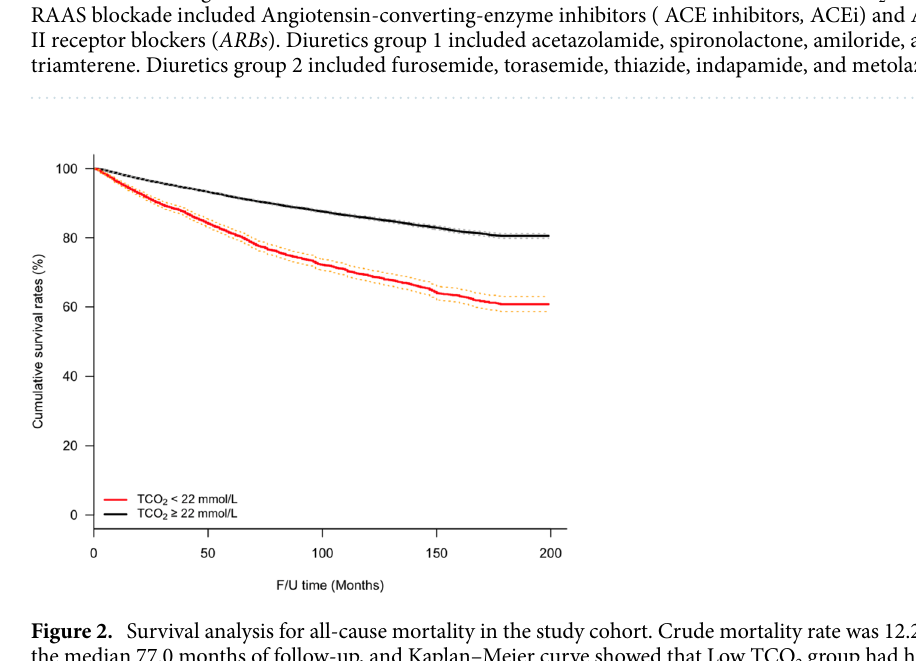
Table 1. Baseline characteristics and demographics according to the stage of chronic kidney disease. The data are expressed as the proportion (%), mean ± SD or median (IQR). BP blood pressure, ESRD end-stage renal disease, GFR glomerular filtration rate, MDRD modification of diet in renal disease, TCO 2 total CO 2 . RAAS blockade included Angiotensin-converting-enzyme inhibitors ( ACE inhibitors , ACEi) and Angiotensin